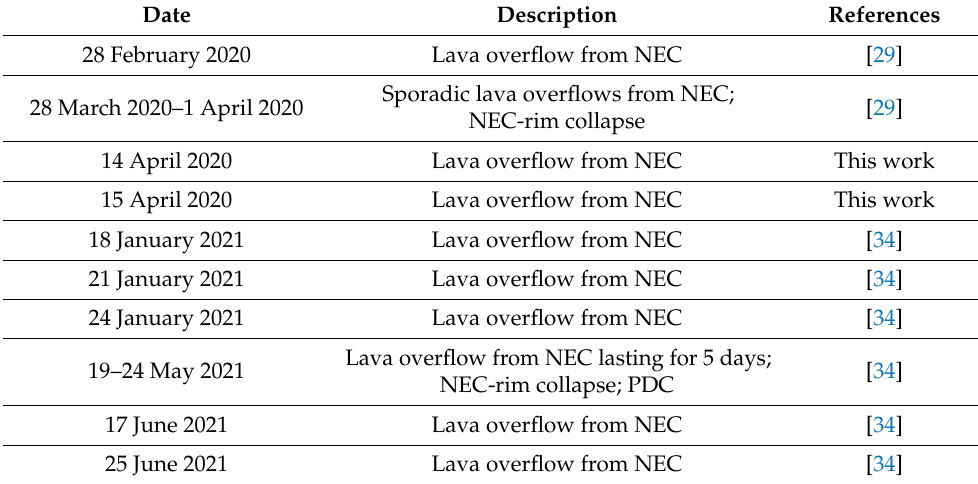
Table 1. The February 2020–June 2021 effusive activity at Stromboli volcano and related crater-rim (NEC) collapses.